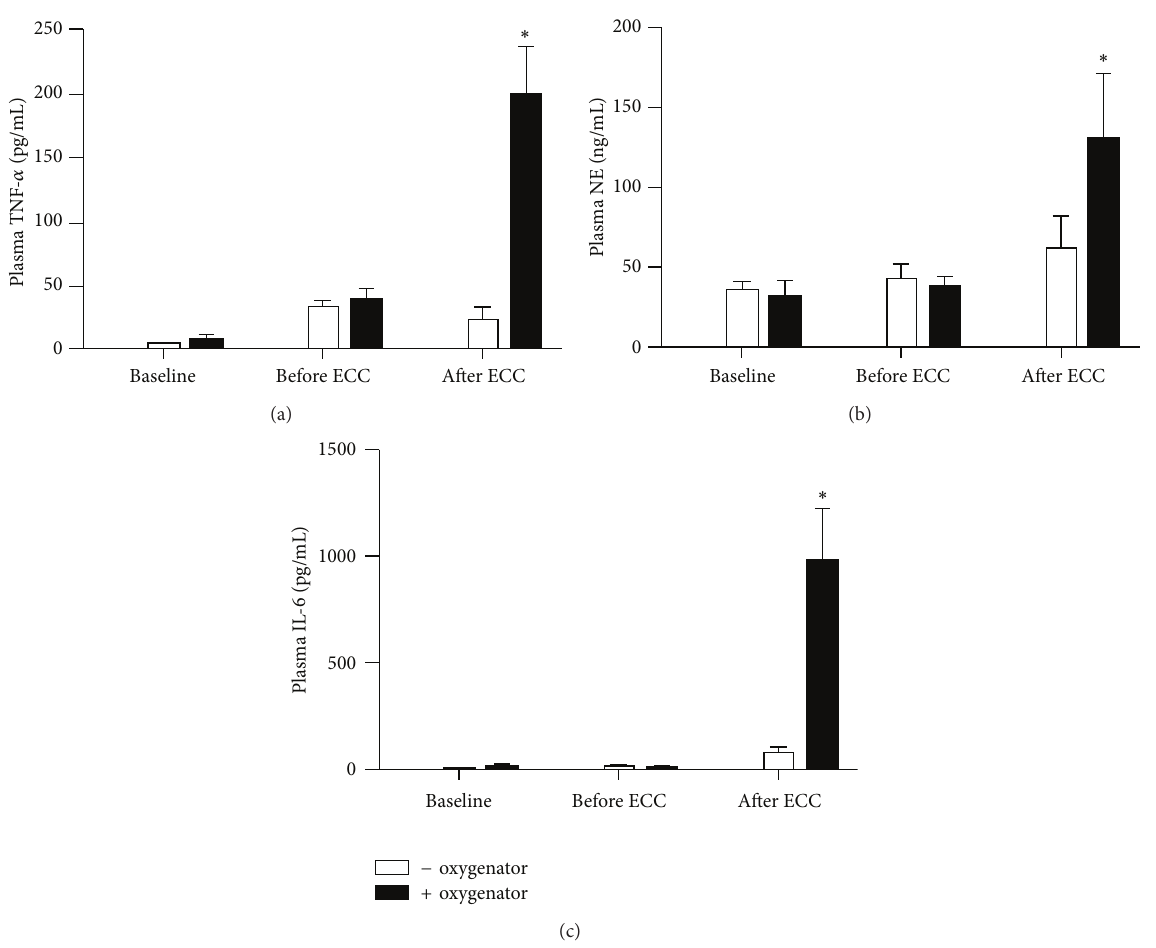
Figure 3: Systemic inflammatory response assessed by TNF- 𝛼 (a), neutrophil elastase (NE) (b), and IL-6 (c) levels in plasma. ∗ 𝑃 < 0.01 versus the other group at the same time point.